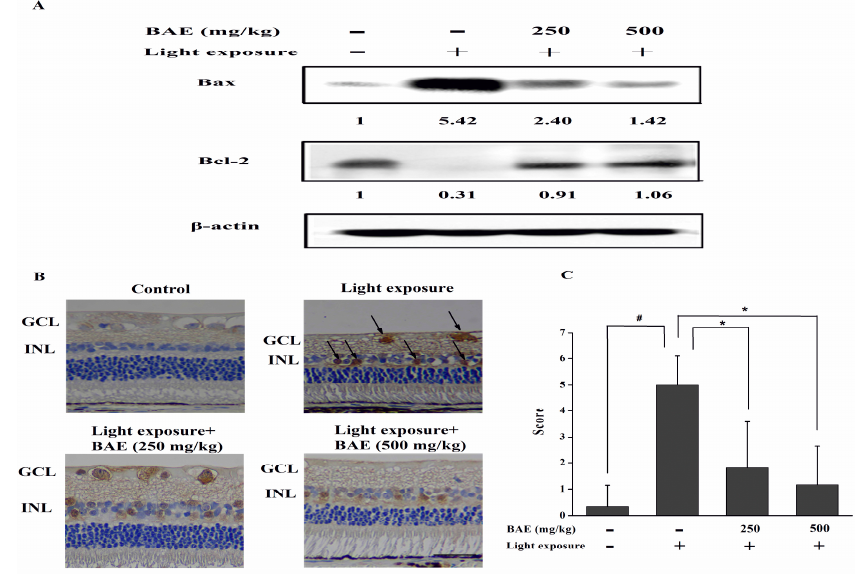
Figure 4. ( A ) Effect of bilberry anthocyanin extract on Bax and Bcl-2 expression in retinas based on Western blot analysis at 7 days after light exposure (18,000 lx). The data are representative of three independent experiments; ( B ) Active caspase-3 expression in retinas at 7 days after light exposure. INL: inner nuclear layer; GCL: ganglion cell layer. Scale bar: 20 μ m; ( C ) Scores were determined by evaluating the extent and intensity of immunopositivity. Data are expressed as the mean ± standard deviation ( n = 6). #, * p < 0.05 ( t -test).